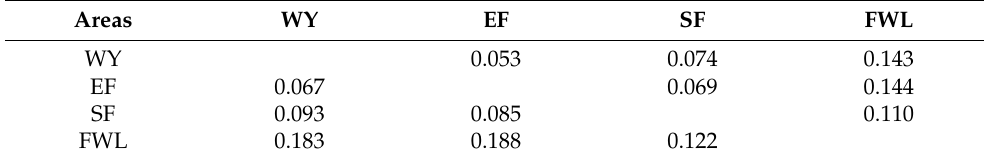
Figure 5. Hierarchical clustering tree of the 137 tea germplasms. Table 4. Matrix of pairwise Nei’s genetic distance and Fst among the four areas.